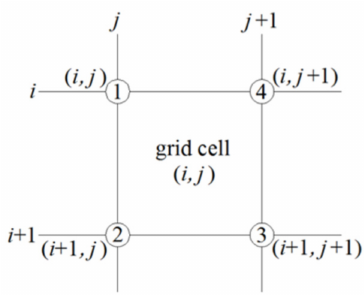
Figure 10. Numbering calculation of nodes constituting a MIKE21 quadrilateral grid cell (“ i ” and “ i + 1” represent the serial numbers of the adjacent longitudinal grid lines; “ j ” and “ j + 1” represent the serial numbers of the adjacent transverse grid lines; the cell serial number is marked by the combination ( i , j ); and “ 1 (cid:13) ~ 4 (cid:13) ” are the node numbers constituting the